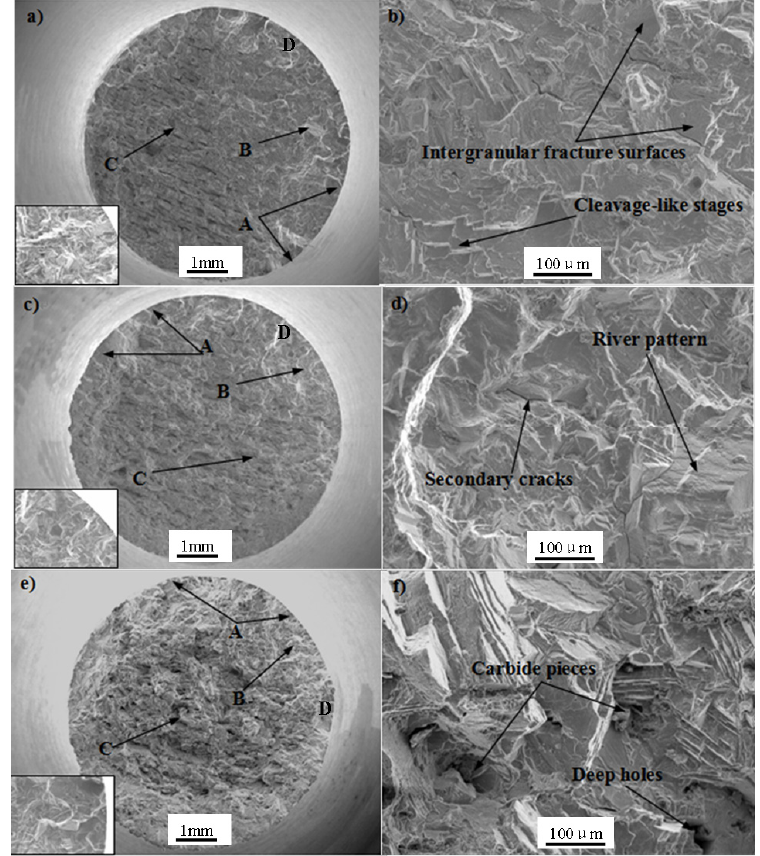
Figure 7. Fractographs of Pro.I after LCF at 650 °C. ( a , b ) Δε t /2 = 0.4%; ( c , d ) Δε t /2 = 0.6%; ( e , f ) Δε t /2 = 0.8%.